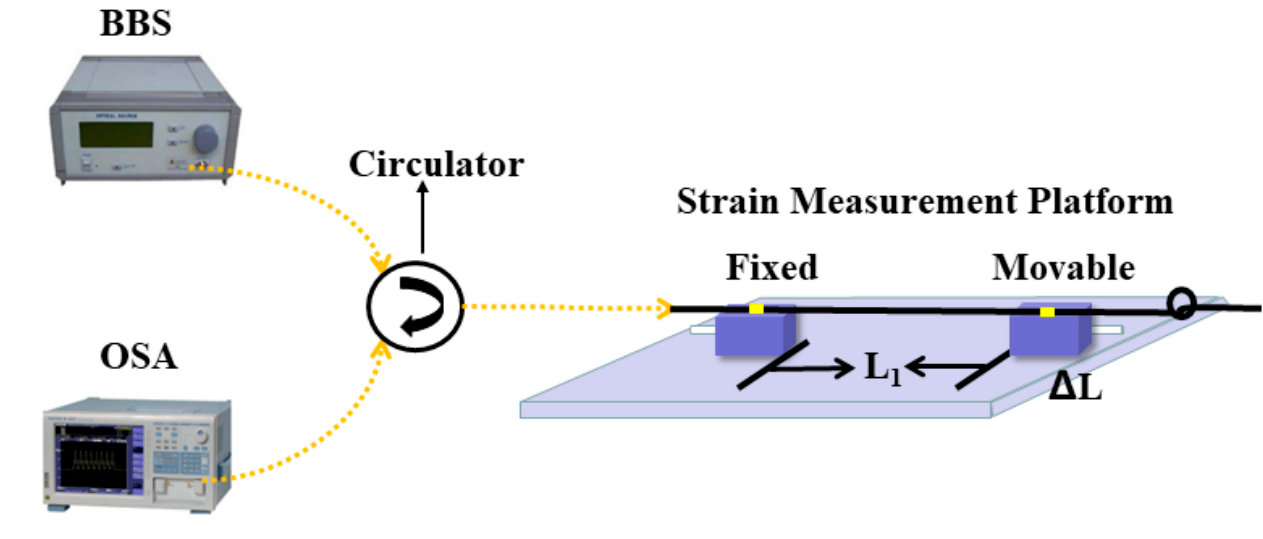
Figure 4. Schematic of strain experimental setup.